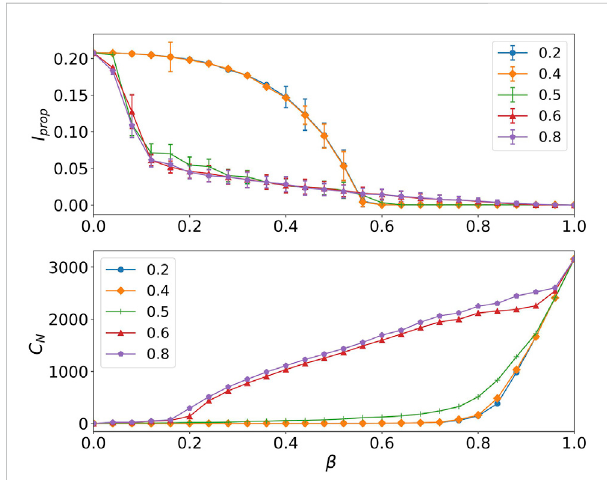
FIGURE 5 The effect of different values of α on network connectivity and epidemic suppression. We show the spread range ( I prop ) and the numberofconnectedcomponents( C N ),asafunctionofthefactionof removed edge ( β ) in GA network, where the numbers in the legend represent thevaluesof α . The error barsof all points areshown in the top